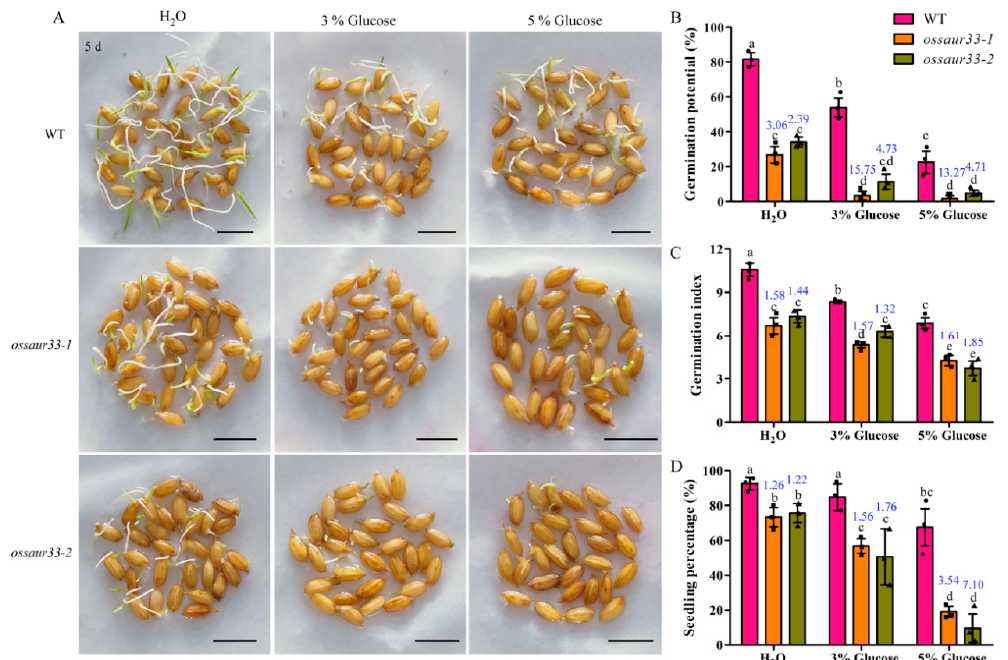
Figure 7. OsSAUR33 regulates seed vigor via in the sugar pathway during early seed germination in rice. ( A ) Seed germination of the WT and the ossaur33 mutants under H 2 O and glucose (3 and 5%) treatments for 5 days. Bars = 10 mm. ( B – D ) Comparison of the germination potential, germination index, and seedling percentage between the WT and ossaur33 mutants under the H 2 O and glucose treatments conditions. The numbers above the box-plots indicate the relative value of the WT compared with that of the mutant. Each column represents the mean ± standard deviation, black small symbol means the value of each replication, n = 3. Different letters above the column indicate significant difference at the 5% level according to an analysis of variance (ANOVA) test.